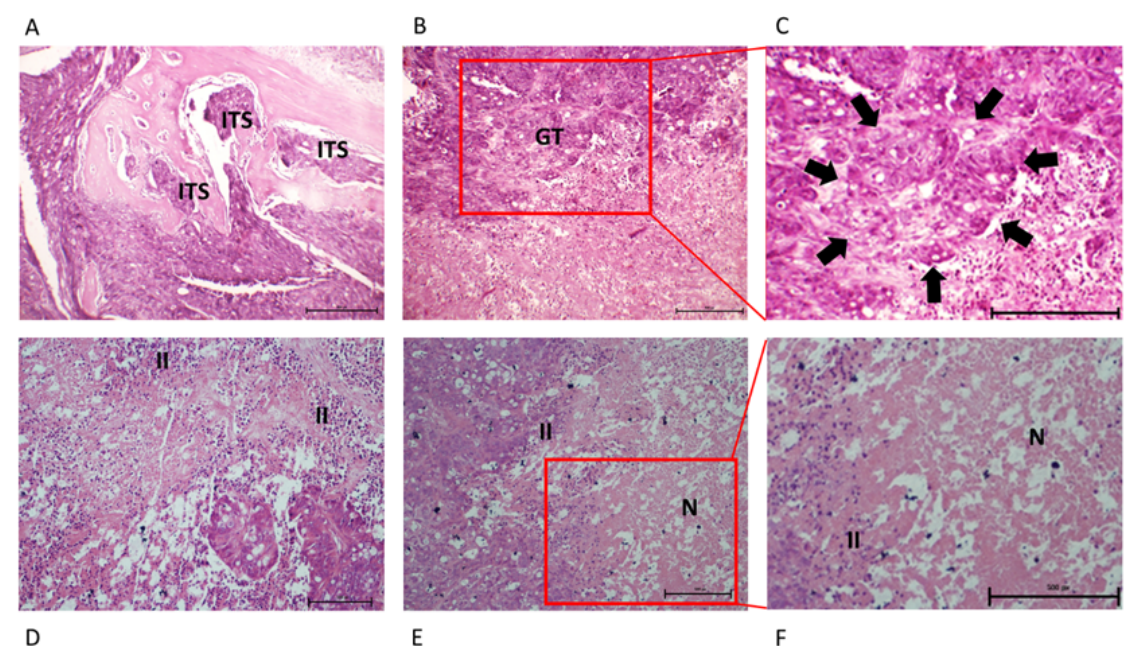
Figure 4. Histopathological characteristics of bone metastasis in colon cancer following inoculation of xenogeneic HT-29 tumor cells (A, B, C) in untreated or (D, E, F) melittin-treated mice (day 27). (A B, C) Metastasis-bearing untreated mice exhibit intense cancer cell invasion into intertrabecular spaces (ITS) characterized by lytic metastasis with bone infiltration, presence of glandular tissue (GT and arrows) and solid sheet areas. (D, E, F) Metastasis-bearing melittin-treated mice exhibit inflammatory infiltrated (II) and necrosis (N) areas without cancer cells. Untreated animals (n = 3); melittin-treated animals (n = 6). H&E, A [40×], B , D and E [100×], C and F [400×].